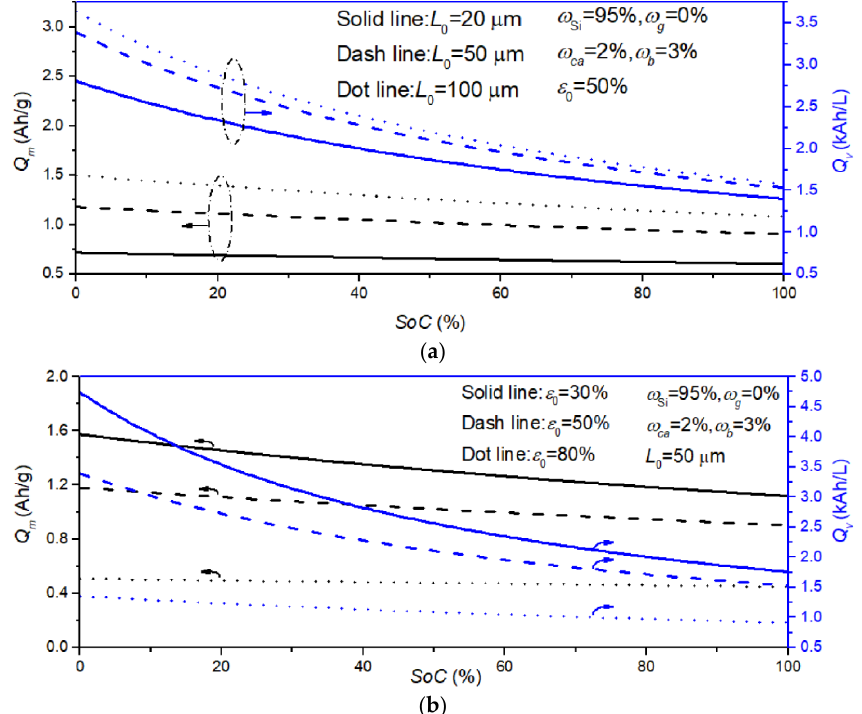
Figure 9. The gravimetric and volumetric capacity as a function of SoC for Si-based electrodes with different ( a ) thicknesses and ( b ) initial porosities.